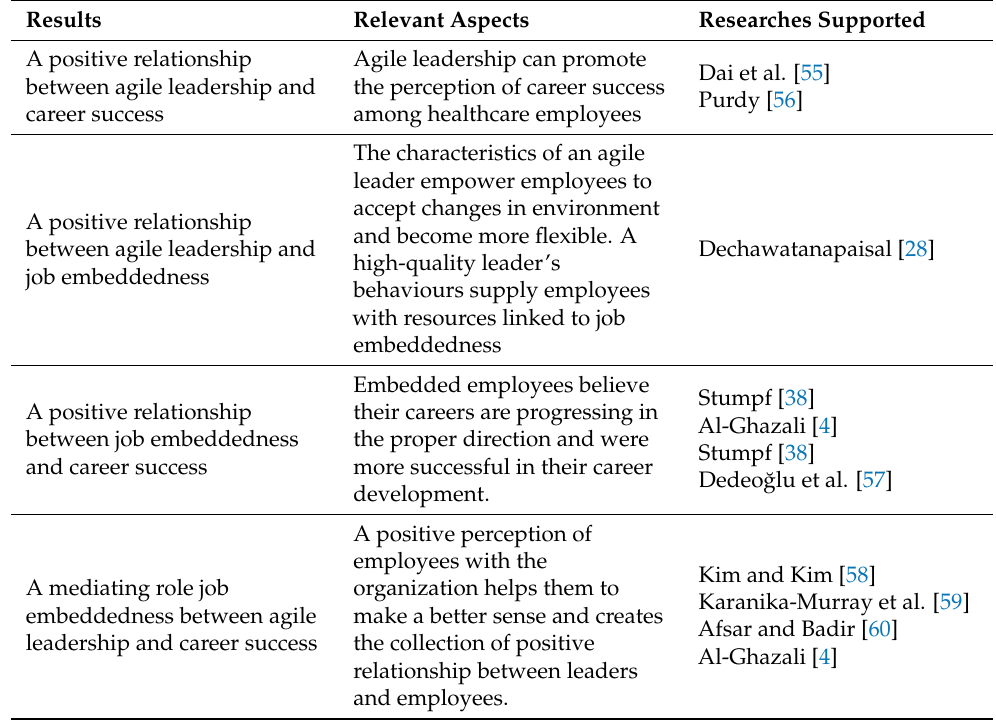
Table 5. Summary of the